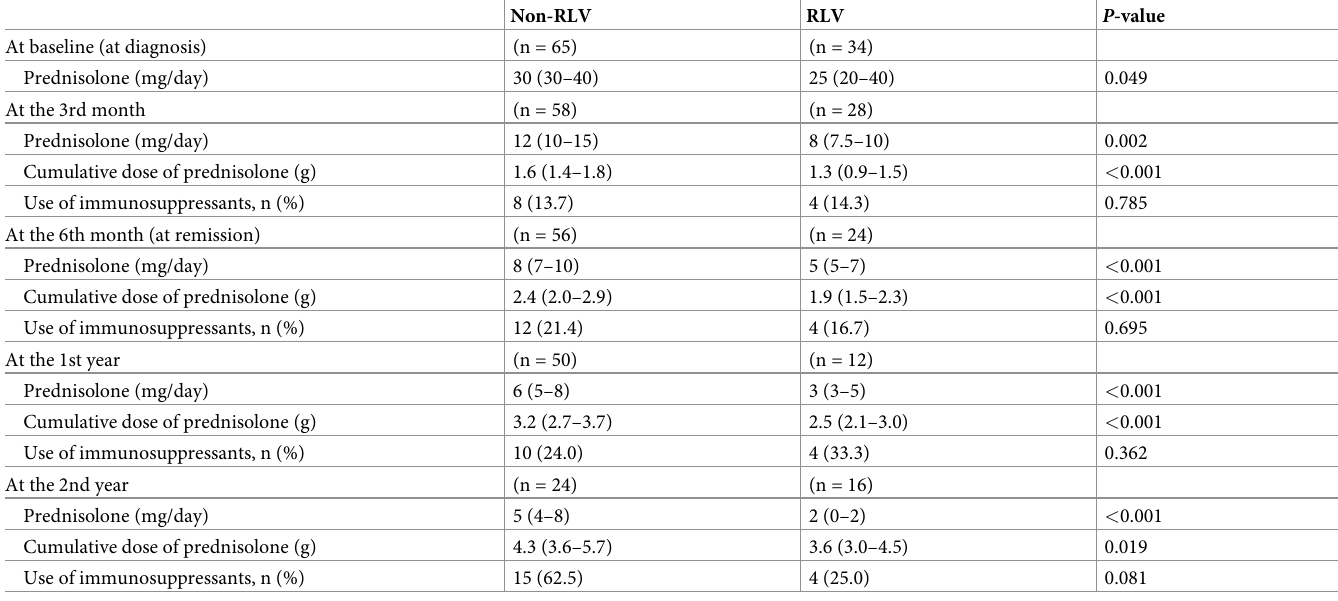
Table 4. Immunosuppressive treatment during the observation